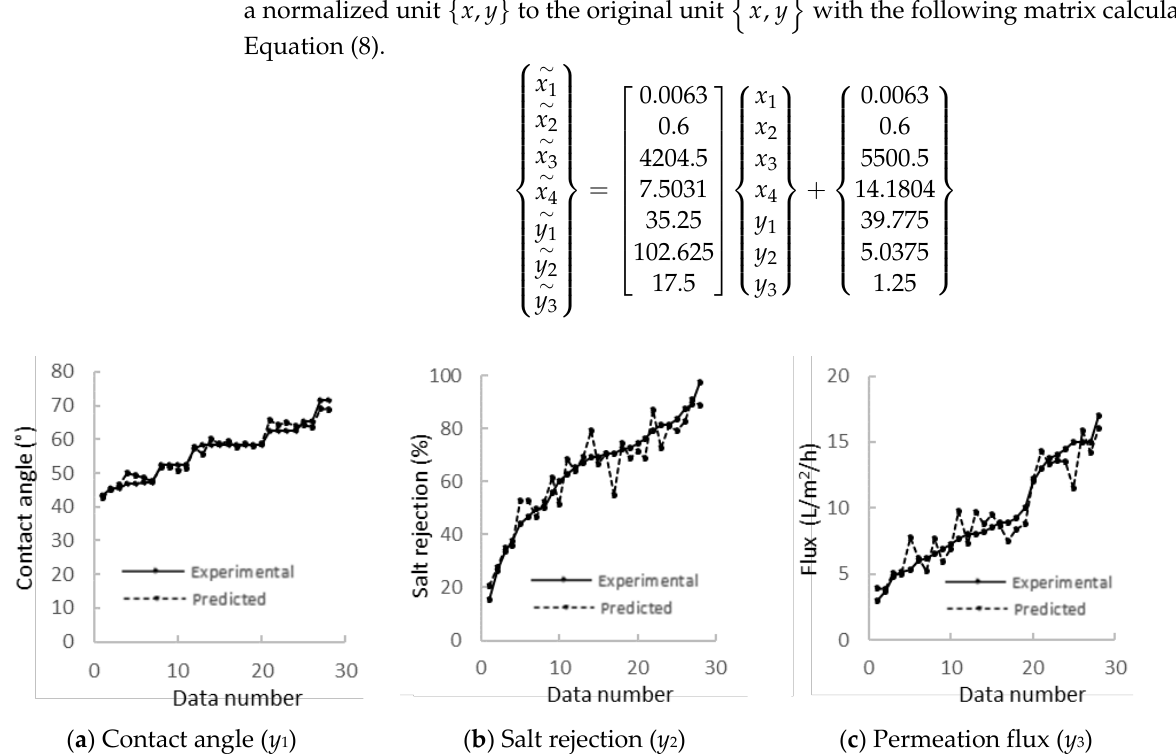
Figure 4. Regression analysis performance of the ANN from Equation (7).